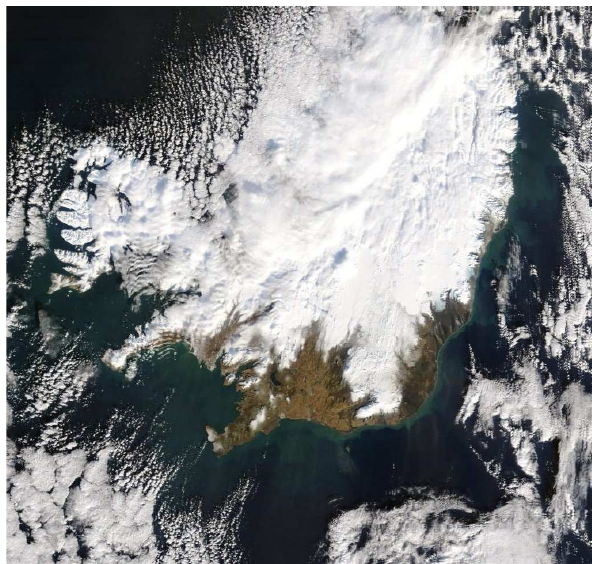
Fig. 6. MODIS Terra true-color satellite image from 25 February 2007 at 13:20UTC (image courtesy of the NASA/GSFC Rapid Re- sponse system,